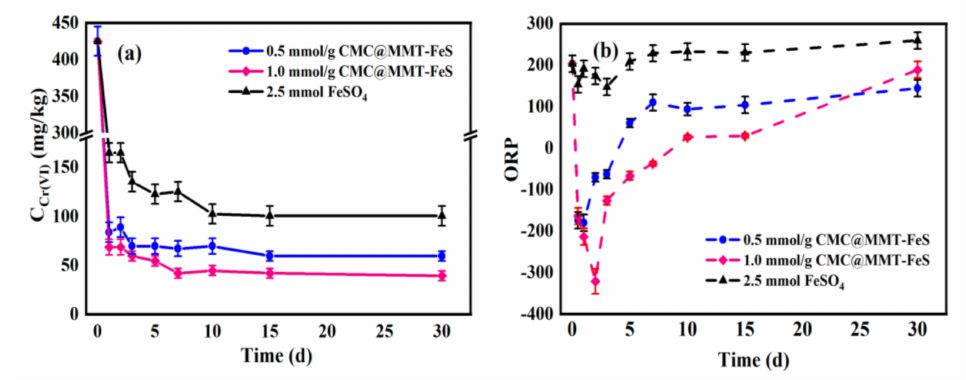
Figure 3. ( a ) The concentration of hexavalent chromium (Cr(VI)) and ( b ) the oxidation–reduction potential (ORP) of soil samples after amendments over 30 days (added composite–soil mass proportion: